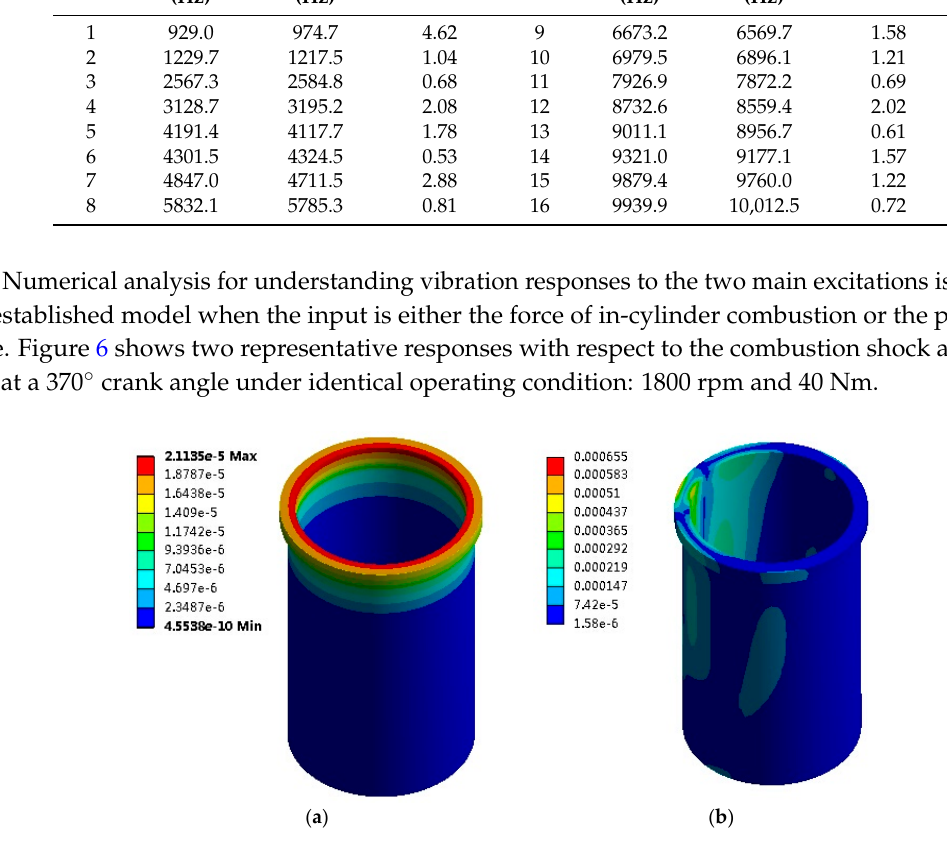
Figure 6. Total deformation of cylinder liner (mm); ( a ) Response to combustion shock; ( b ) Response to piston slap. piston